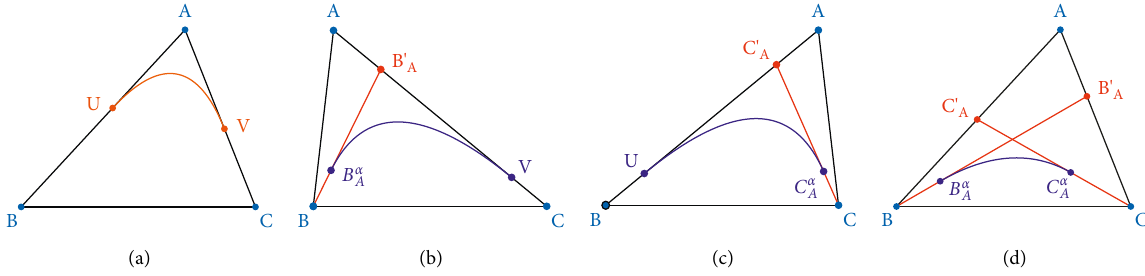
Figure 5: E ( ∠ A, α p ) ∩ D in (a) Lemma 5.1, (b) Lemma 5.2, (c) Lemma 5.3, and (d) Lemma α